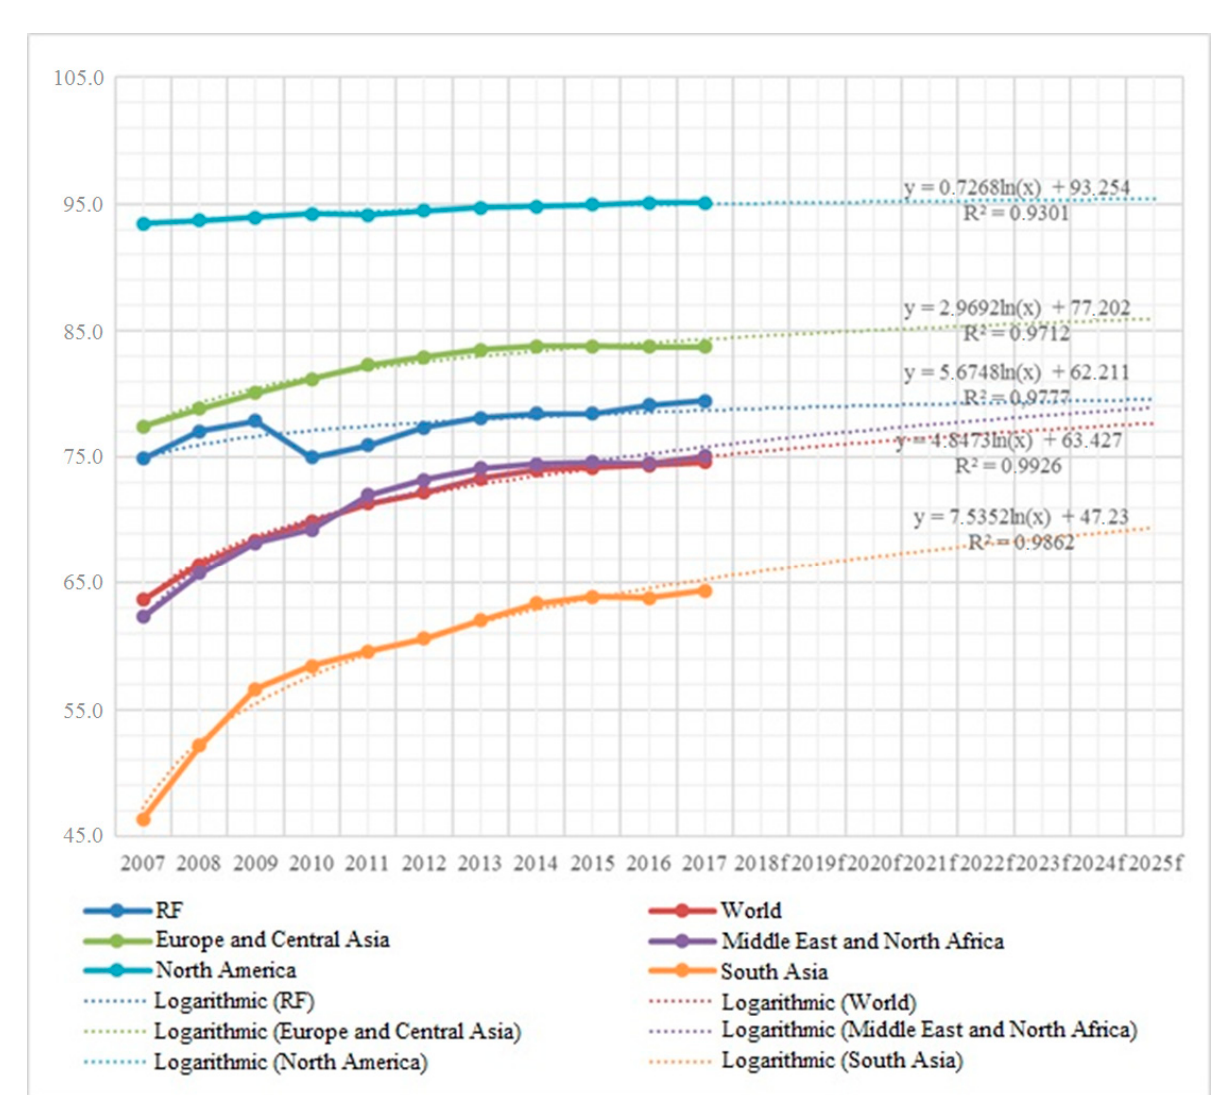
Figure 2. Information globalisation in Russia, on the global scale, by regions and sociocultural communities globally.